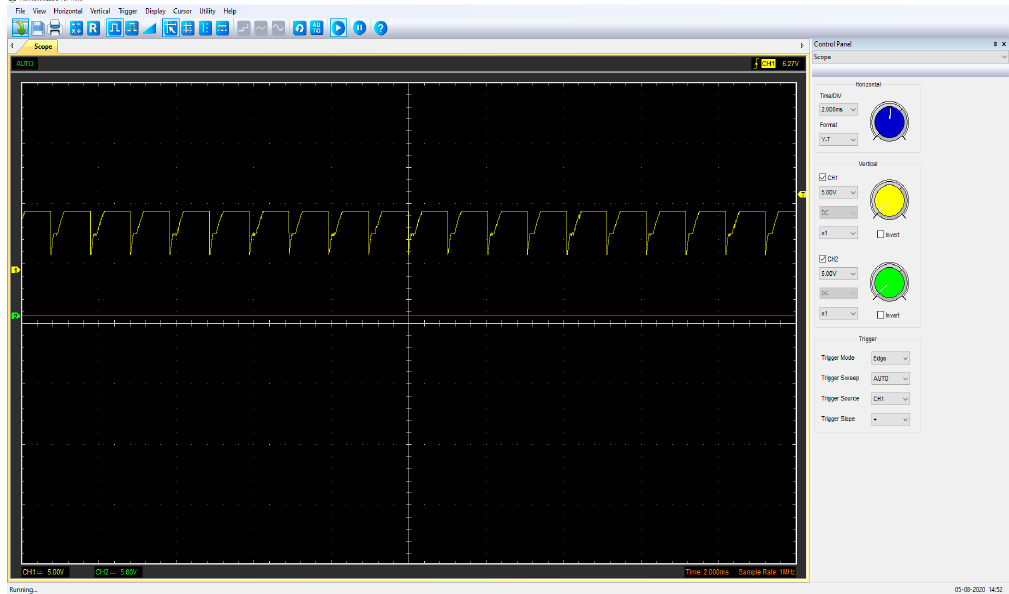
Figure 22. Switching wave on MOSFET Source when transitioning.